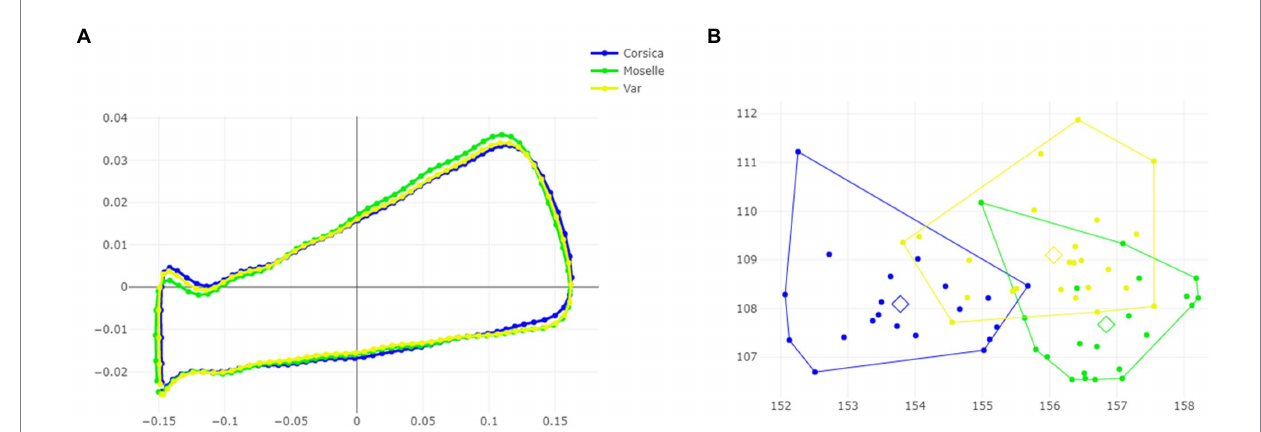
FIGURE 6 Shape variation of Culicoides circumscriptus based on outlines-1. Superposition of the geometric morphometric set landmarks (A) in three geographically distant sites. Factor map of the two discriminant factors (DFs) among three sites (B) . Each point represents an individual. The horizontal axis is the first DF; the vertical axis is the second DF; their cumulated contributions reach 100% of the total variation.